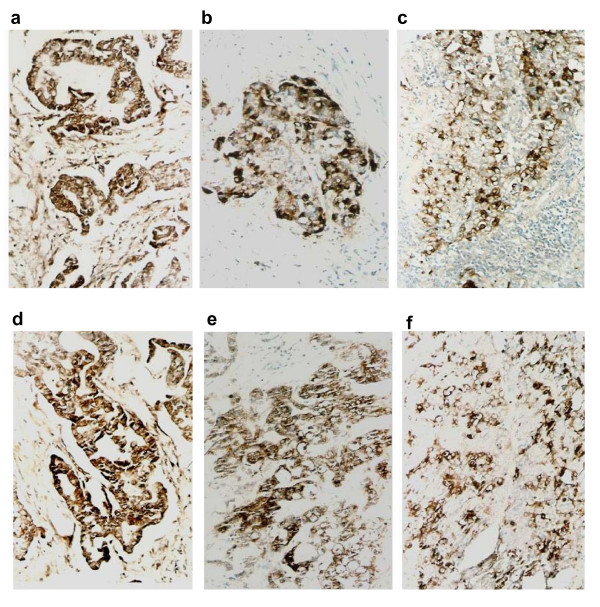
Expression of p-ERK1/2 and PI3-K (original magnification 200×). Expression of p-ERK1/2 in well-differentiated gallbladder adenocarcinoma (a), moderately-differentiated gallbladder adenocarcinoma (b), and poorly-differentiated gallbladder adenocarcinoma (c); PI3-K expression in well-differentiated (d), moderately-differentiated (e), and poorly-differentiated gallbladder adenocarcinoma (f).